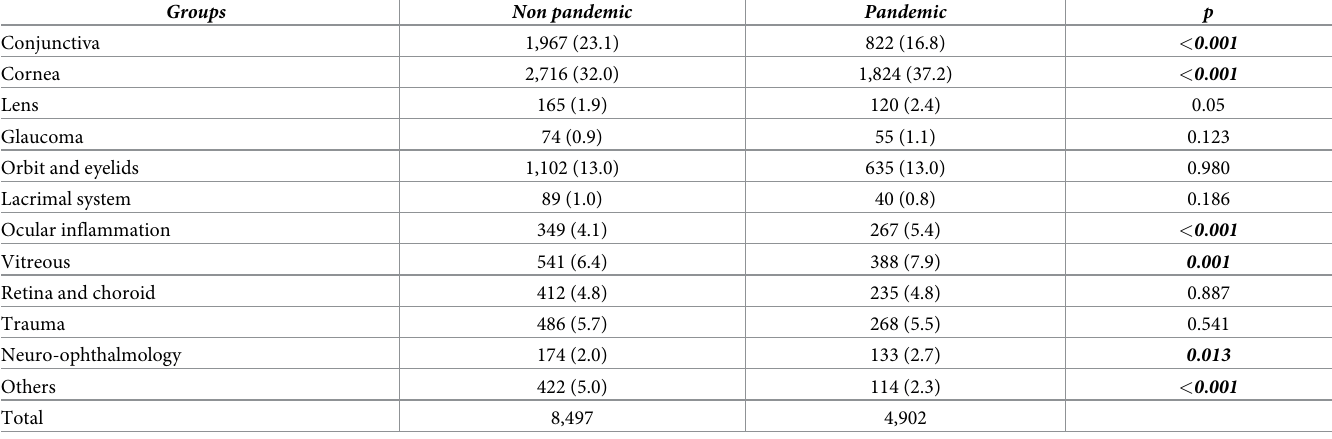
Table 4. Number of diagnoses categorized by group in six representative months after the COVID-19 pandemic outbreak (September 2020–February 2021) com- pared with the same period of the year before. Groups